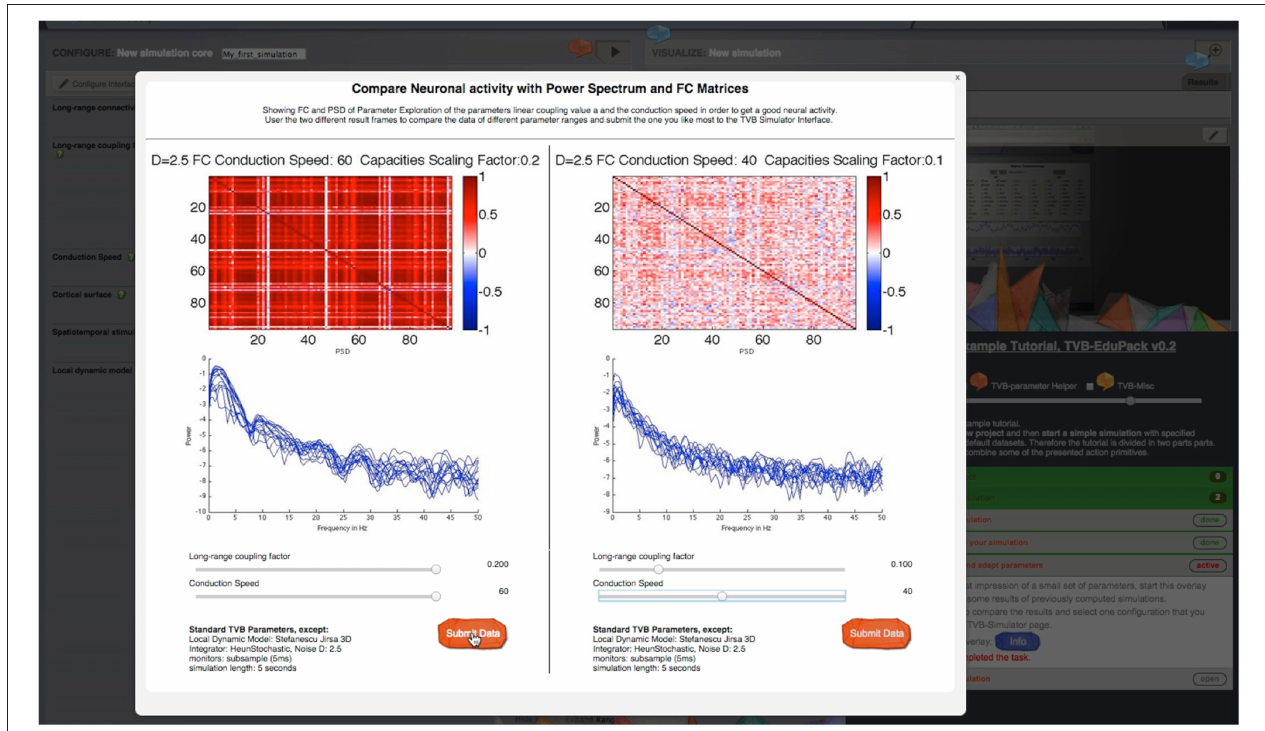
FIGURE 8 | Parameter regime exploration tool: Sliders are used to set different simulation and model parameters. Pre-computed simulation results show the associated dynamics for different metrics of interest like FC or power spectral density. Thereby, users can quickly determine meaningful parameter ranges for their own